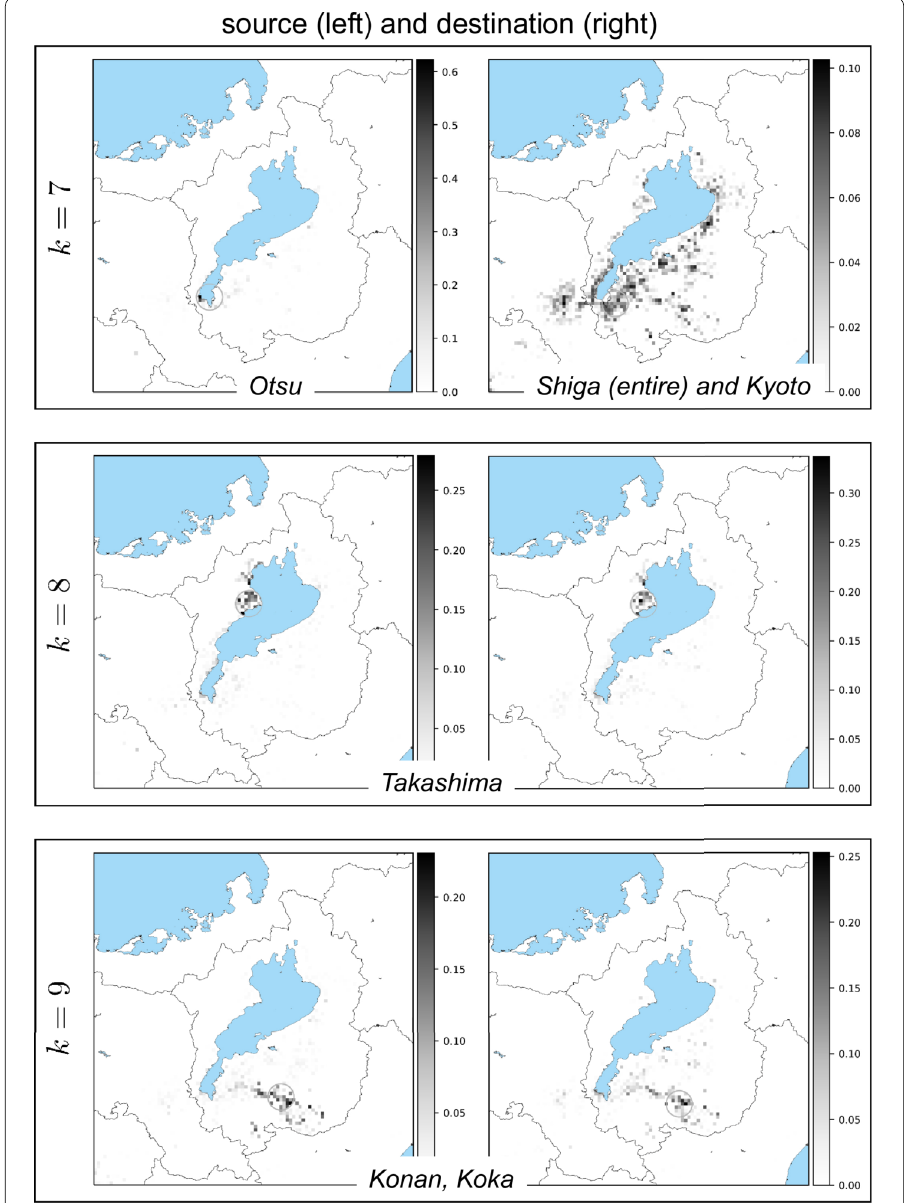
Figure 13 Each box shows a pair of NMF basis vectors w k (left) and h k (right). From top to bottom: k = 7,8,9. See the caption of Fig. 11 for explanation. Note that for the box k = 7, the basis h k =7 (right figure) has its vector components of destination widely distributed over the Shiga prefecture and its neighbor in Kyoto, which is located to the left (west) of Shiga. So, in this exceptional case, the figure does not include a circle corresponding to any peak of vector components